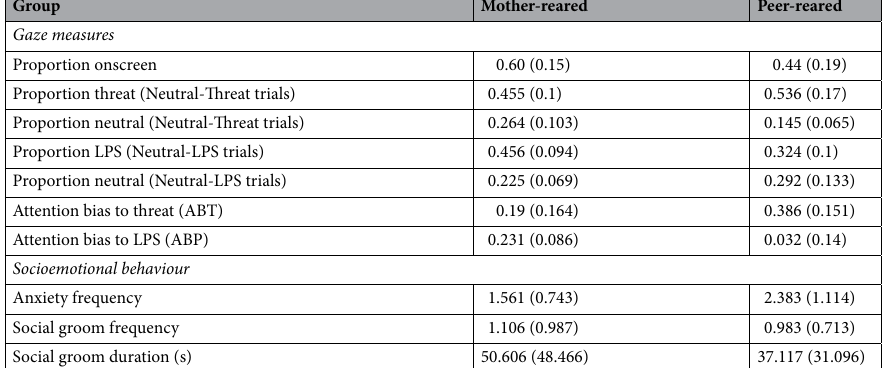
Table 1. Gaze measures and socioemotional behaviours. Proportion onscreen is the proportion (M and SD) of trial time spent attending to the screen. Proportion threat, neutral, and LPS are the proportions (M and SD) of time attending to the screen spent attending to the threat, neutral, and LPS stimuli, respectively. ABT and ABP (i.e. affective versus neutral stimuli) is the difference between proportions to threat (or LPS) and neutral in the neutral-threat, and neutral-LPS trials, respectively. Anxiety and social groom frequency are the frequencies (M and SD) of anxiety-like behaviour and social grooming during the behavioural observation period. Social groom duration (M and SD) is the total amount of time (seconds) spent in grooming interactions during the behavioural observation